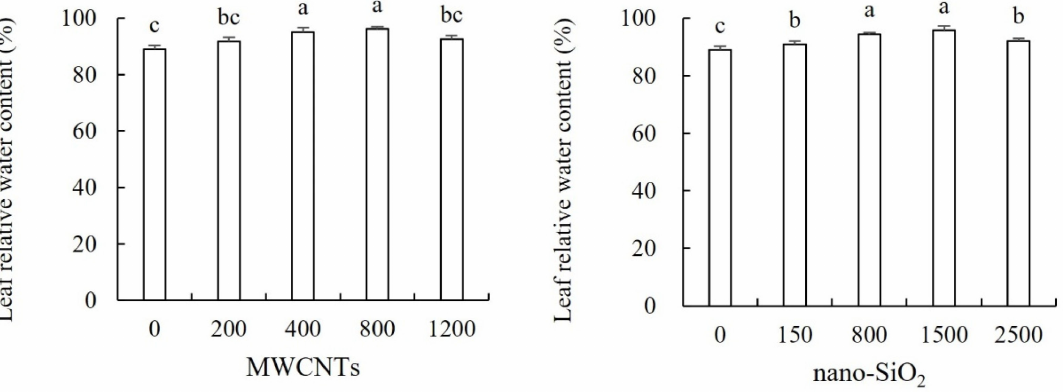
Figure 2. Effect of different concentrations of MWCNTs and nano-SiO 2 on relative water content in maize. Note: Data are expressed as mean ± standard deviation. Different letters within the same column indicate significant difference at 5%